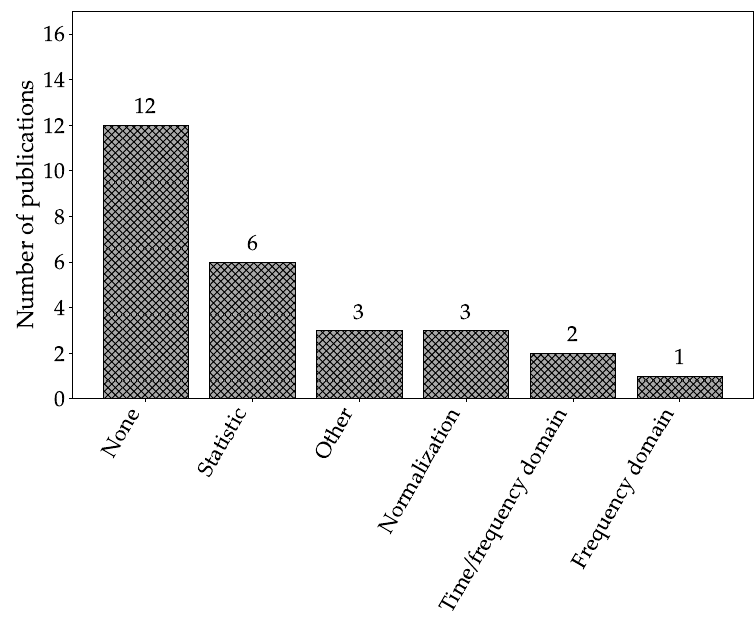
Figure 13. Repartition of pre-processing for fuzzy techniques.